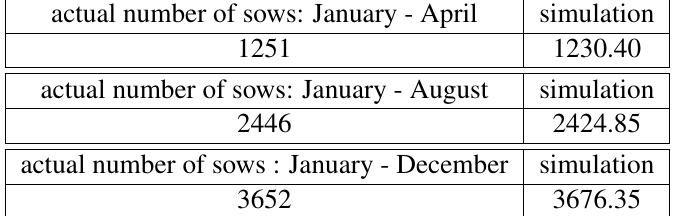
Table 1 Comparison between the actual and the simulated number of